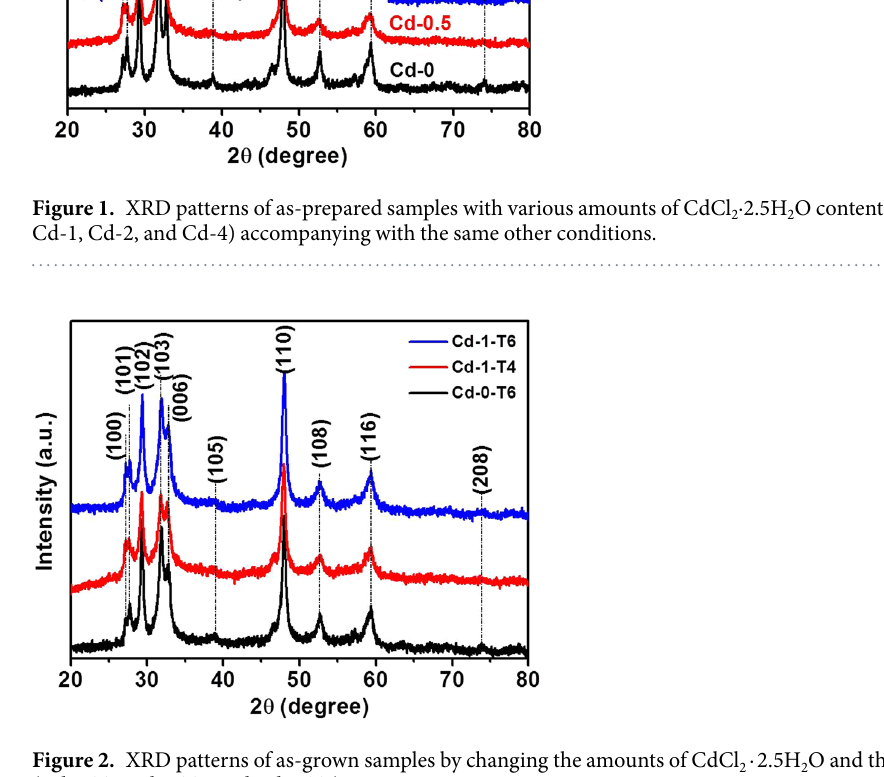
Figure 2. XRD patterns of as-grown samples by changing the amounts of CdCl 2 · 2.5H 2 O and thiourea contents (Cd-1-T6, Cd-1-T4, and